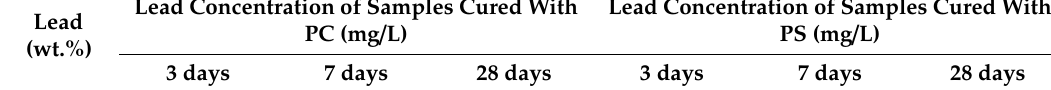
Table 2. Lead concentration of samples stabilized with different materials at different ages.